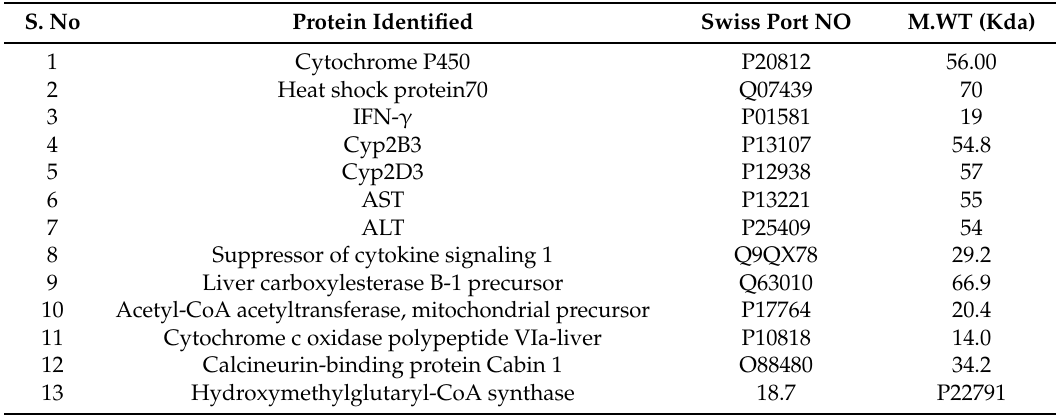
Table 4. High differentially expressed proteins in rats received 1500 mg/kg of APAP.